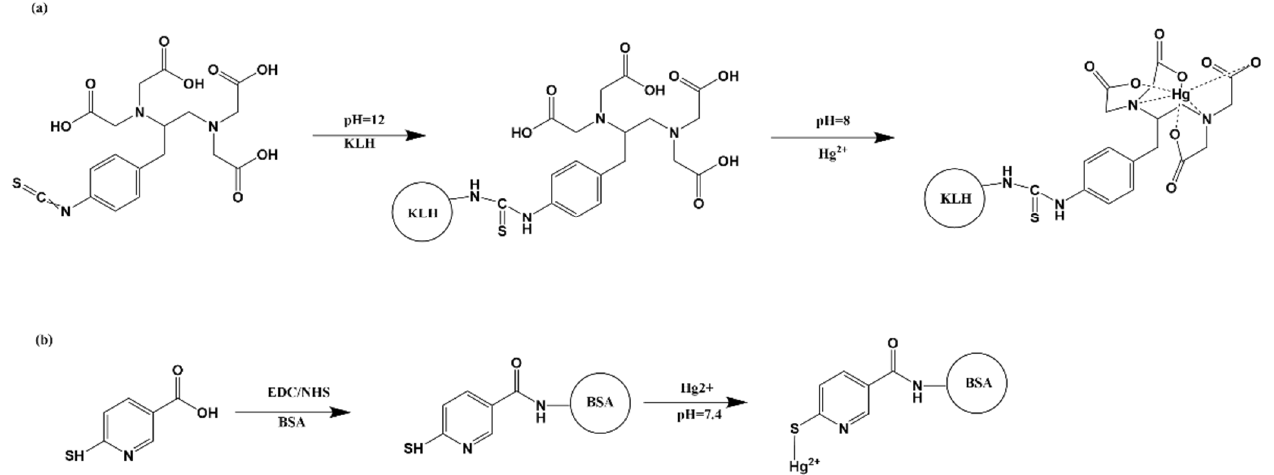
Figure 1. ( a ) The scheme of synthesizing immunogen (Hg-ITCBE-KLH). ( b ) The synthesis of coating antigen (Hg-MNA-BSA).